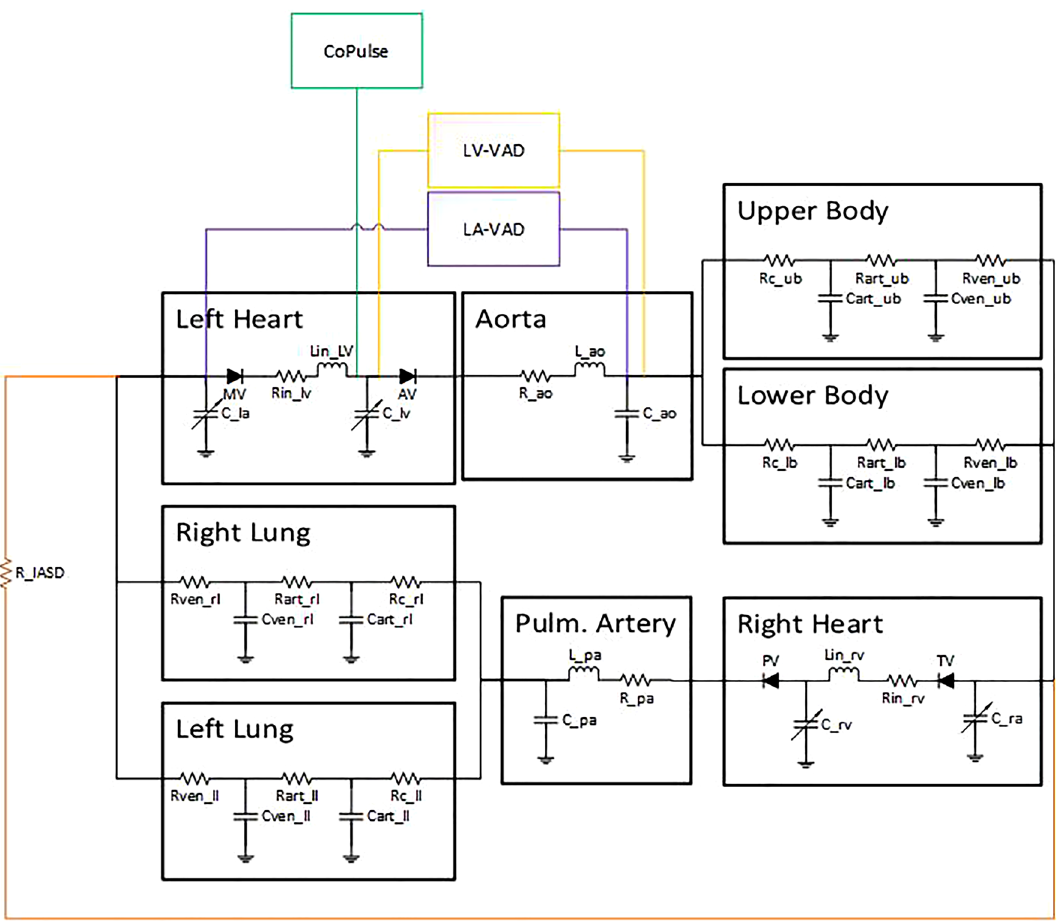
Figure 1. Electrical analogue of the numerical model of the cardiovascular system including the schematic pathways of the four different treatment strategies. Details on model parametrization are provided in Table